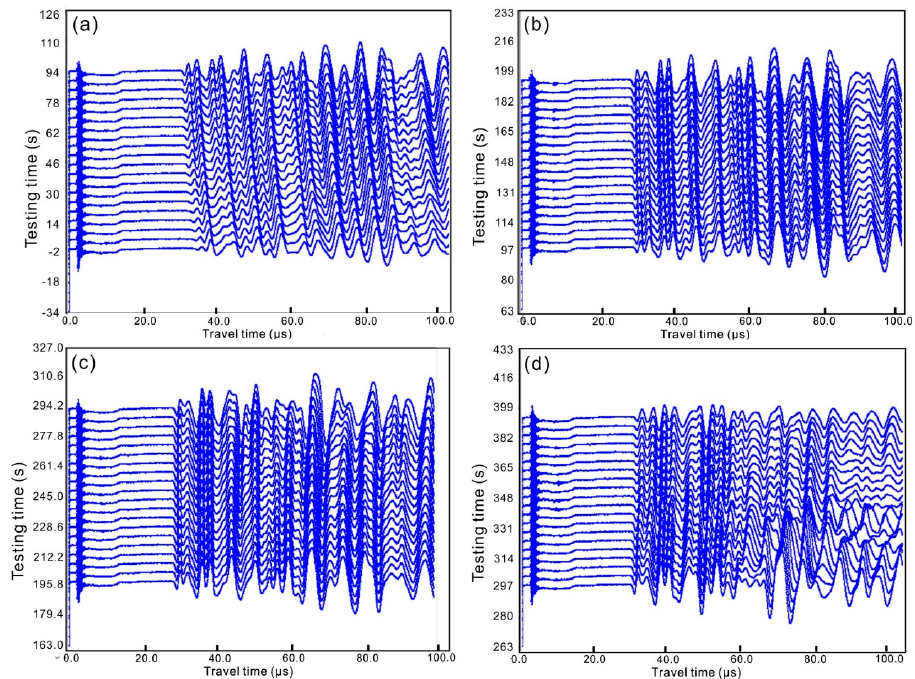
Figure 10. Waveform of P-wave for granite subjected to 100 F–T cycles during uniaxial deformation. The labels ( a – d ) indicate the four parts of the full waveform. The duration of the testing was 0–395 s.